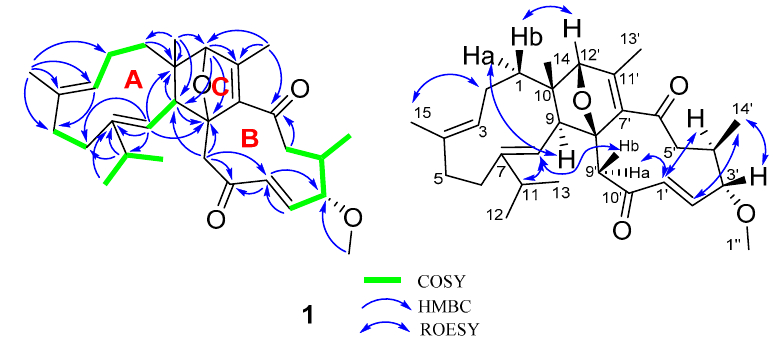
Figure 2. Key 1 H- 1 H COSY and HMBC correlations for 1 .